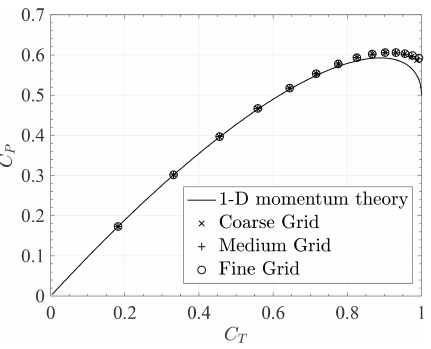
Figure 4. Comparison of axisymmetric RANS actuator disc model with 1-D momentum actuator disc